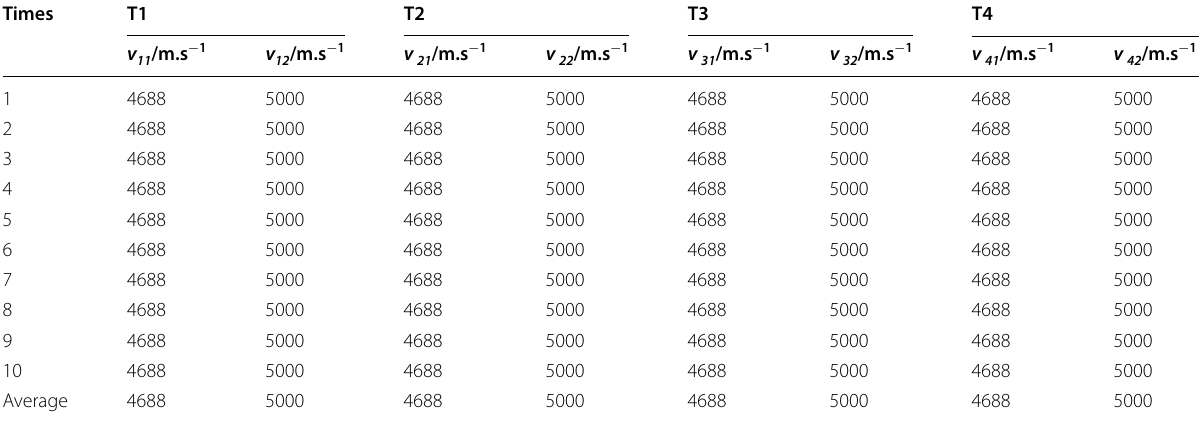
Ten independent experiments were carried out on the four specimens, the experimental results are shown in Table 2, where v i1 and v i2 ( i propagation velocity at a distance of 150 mm and 300 mm, respectively